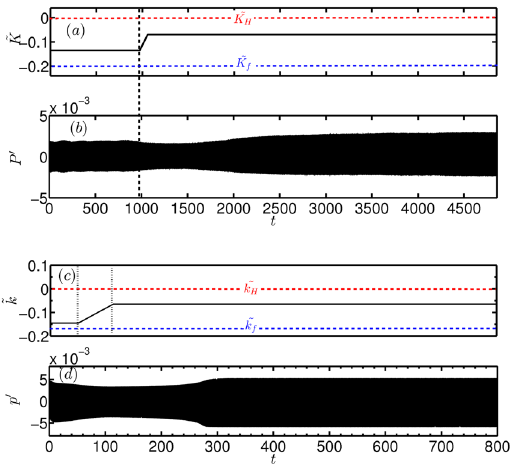
Figure 3. Preconditioned rate induced tipping observed in experiments and in the mathematical model of a thermoacoustic system. ( a ) The variation of heater power with time in experiments. The red and blue horizontal ∼ ∼ lines denote the values of K H (Hopf point) and K f (fold point) obtained from a quasi-static bifurcation experiment. The heater power is varied such that the system is within the bistable zone ( b ) The variation of .∼ acoustic pressure with time in experiments. The value of the control parameter is maintained at = − K 0 135 0 and an initial excitation of amplitude which is within the basin of attraction of the fixed point is provided to the system using loudspeakers, and then the speakers are switched off. The vertical dashed line indicates the time .∼ stamp at which the loud speakers are switched off ( t = 971). Then, the heater power is increased to = − K 0 07 e −∼ ∼ following β = + K K t ( 971) 0 where β = 6.07 × 10 − 4 . As a result, the system tips to the oscillatory state. ( c ) The variation of non-dimensional heater power with time in the mathematical model. The red and blue dashed horizontal lines denote the Hopf and fold points. The value of the non-dimensional heater power is maintained at = − .  k 0 145 which is slightly greater than the value of  k at the fold point up to t 0 = 50. Then the non- 0 dimensional heater power is increased from = − .  k 0 145 to = − .  k according to the relation 0 α = −  ) , where α = 1.29 × 10 − 3 . ( d ) The variation of non-dimensional acoustic pressure with time 0 0 shows that the system tips to limit cycle oscillations after the change in  k . The parameters involved in the model are included in Methods summary.